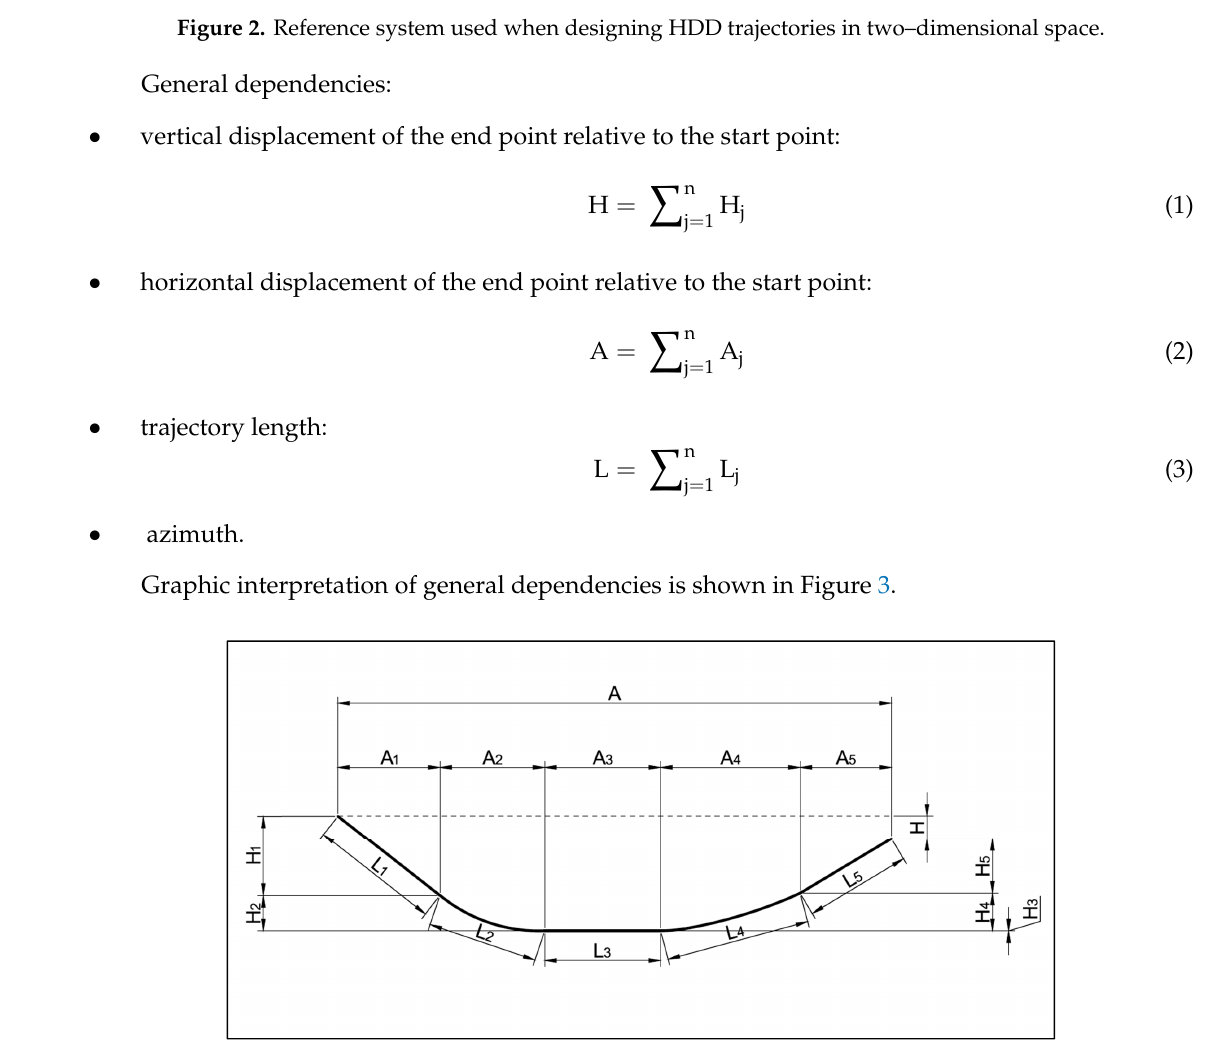
Figure 3. General geometric dependencies.